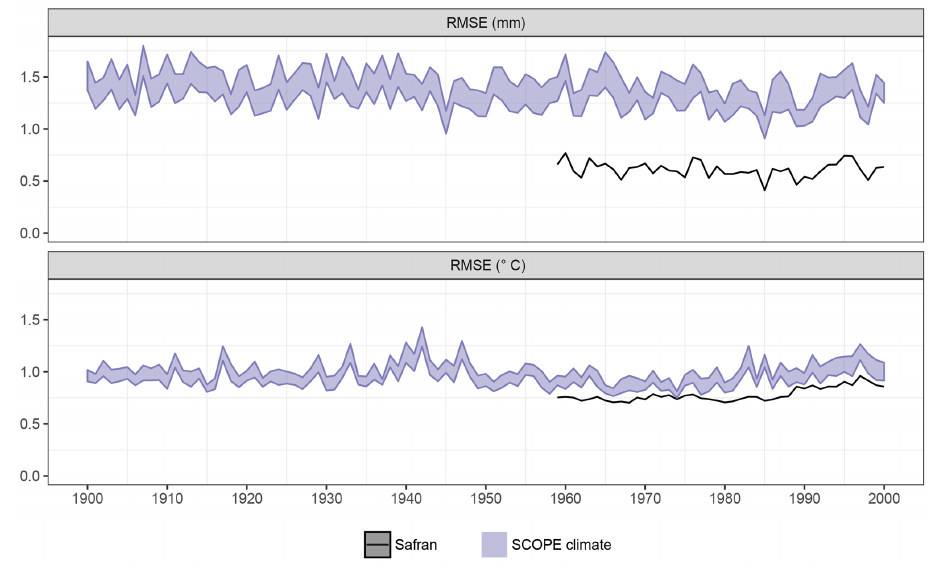
Figure 12. Temporal evolution of the precipitation and temperature RMSE for both Safran and SCOPE Climate, with the homogenized series as a reference. Values are initially computed on the monthly timescale. See text for details.